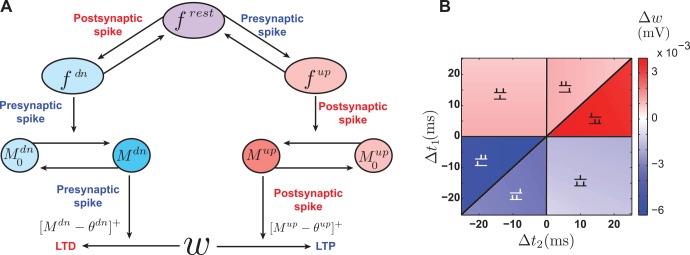
The NMDAR-based model.A. Schematic illustration of spike interactions in the NMDAR-based model. The presynaptic spike up-regulates frest, activates Mdn and depresses the synapse. The postsynaptic spike down-regulates frest, activates Mup and potentiates the synapse. B. Plasticity in the NMDAR-based model due to triplets of spikes with parameters as in Table 2. The effect is asymmetric, with pre-post-pre triplets inducing potentiation (top left) and post-pre-post depression (bottom right).